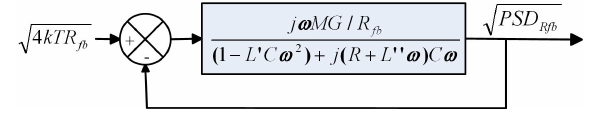
Figure 9. Block diagram representation of the feedback resistance noise